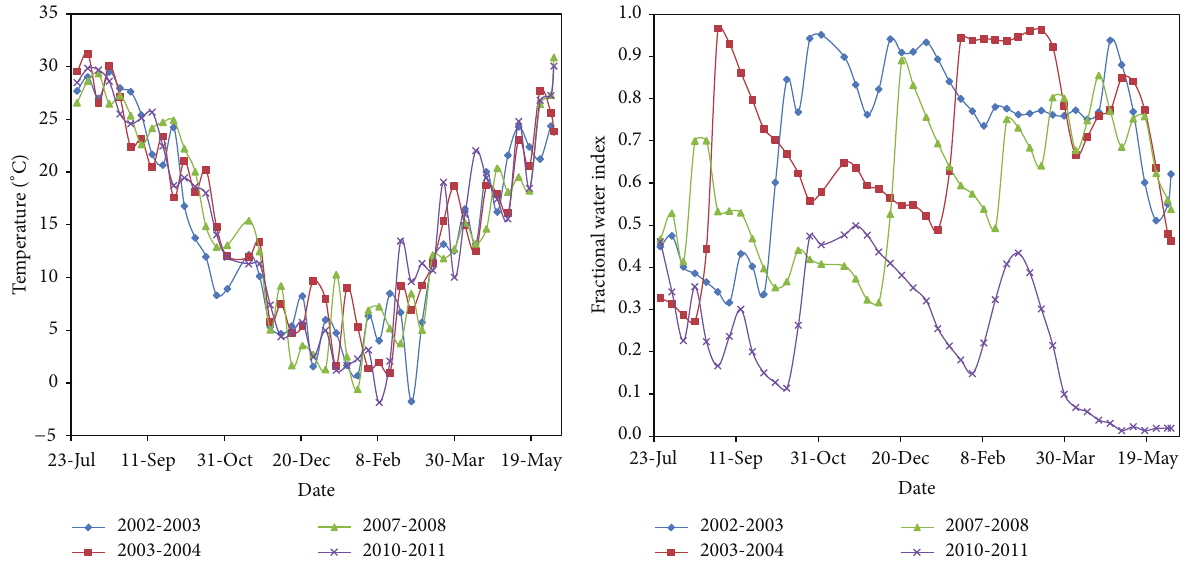
Figure 2: Average weekly air temperature and fractional water index for Altus, Oklahoma, from the average time of preplant irrigation to the average time of grain harvest for years analyzed. Data obtained from the Oklahoma Mesonet climate monitoring station